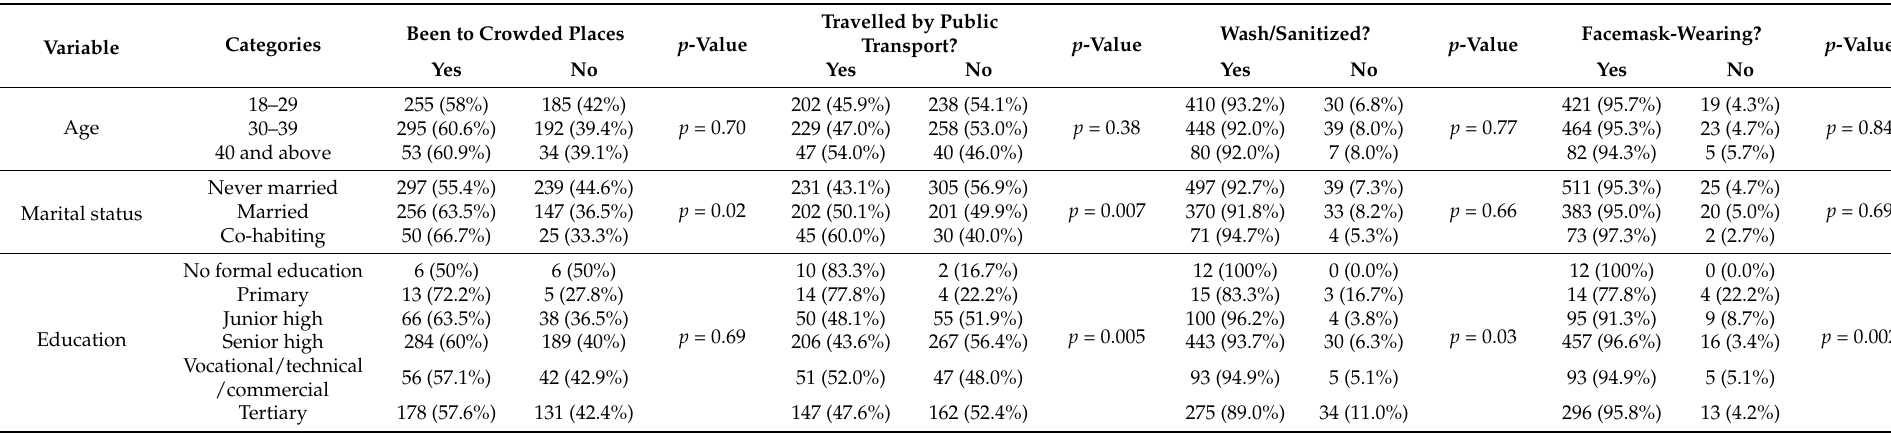
Table 5. Recent practices by the socio-demographic background of participants.